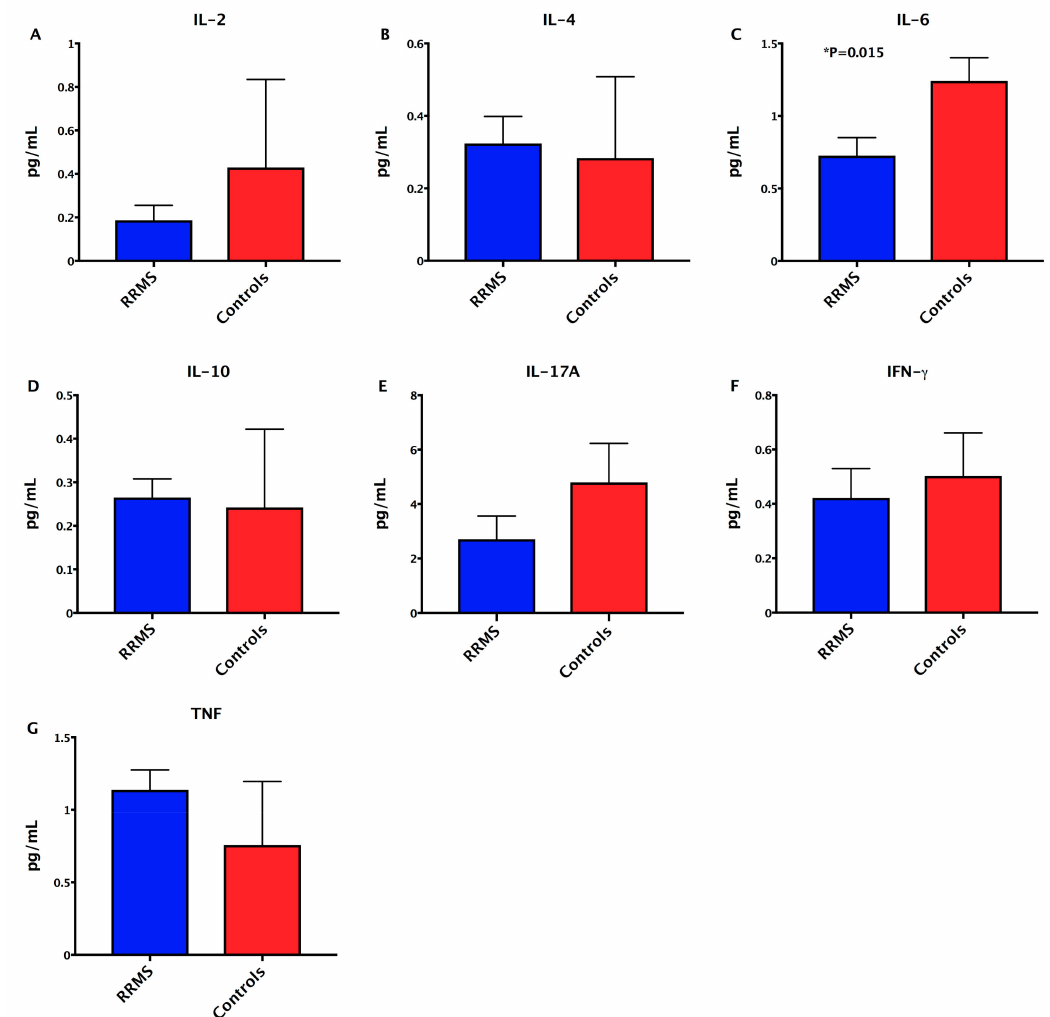
Figure 4. Cytokine profile in treated RRMS patients and control subjects. Serum concentrations of ( A ) IL-2, ( B ) IL-4, ( C ) IL-6, ( D ) IL-10, ( E ) IL-17A, ( F ) IFN-gamma, and ( G ) TNF. Statistical analyses were performed by the Mann–Whitney test. Significance was set at p < 0.05.